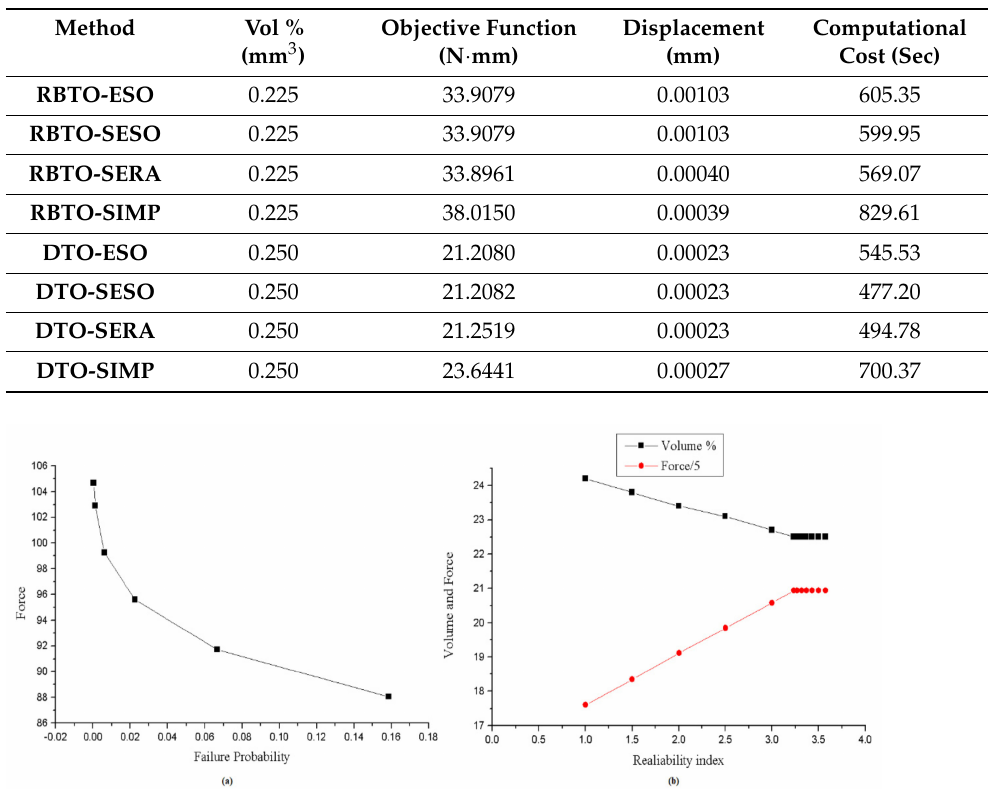
Figure 16. Graphics: ( a ) force by failure probability and ( b ) volume and force by reliability